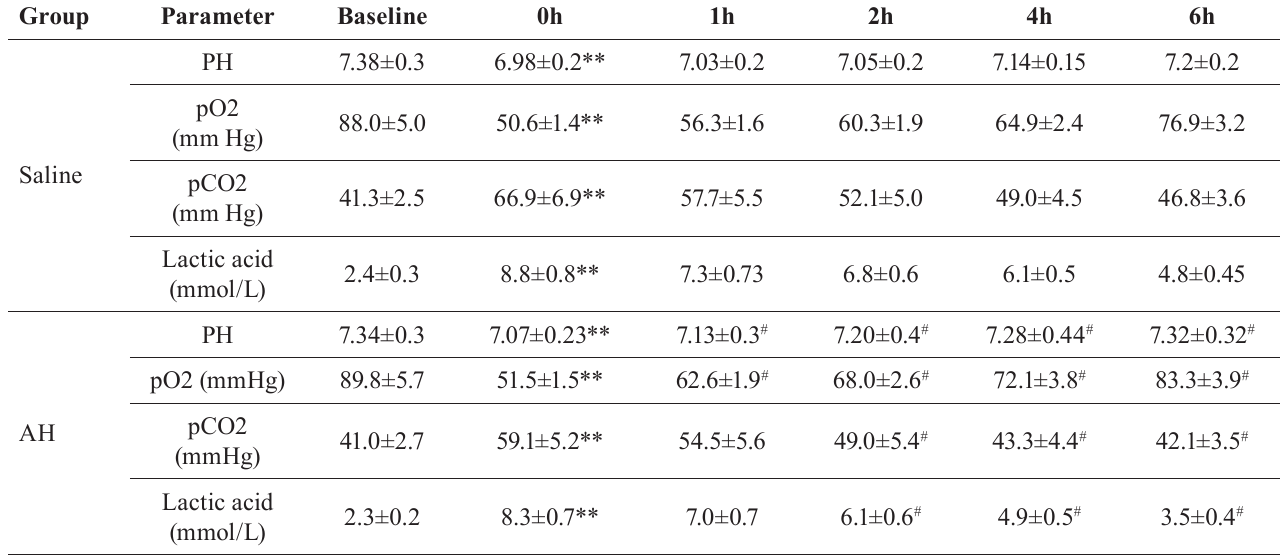
TABLE III - Comparison of arterial blood gas at different time points after ROSC Group Parameter Baseline 0h PH